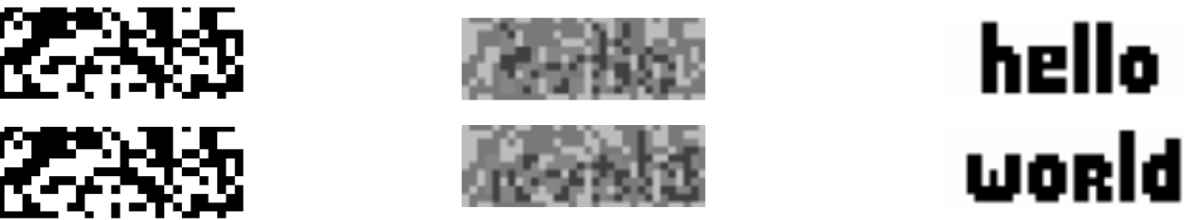
Figure 11. Multiple trigger images for a “hello world” example. A sequence generated by rule set f 6 . Left: the middle section of the bias image (shown twice). Middle: the corresponding sections of the first and second trigger images. Right: the target afterimage patterns ( a 1 , a 2 as before). This sequence also demonstrates the effects of scrambling when using finer target shapes.